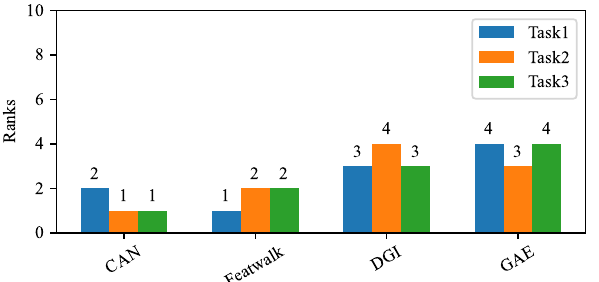
Figure 4. Overall ranks of unsupervised NRL algorithms for attributed networks, evaluated by FURL. We visualize the ranks of each selected pure network embedding algorithm using a bar chart. The algorithms are sorted by their overall ranks in ascending order, from left to